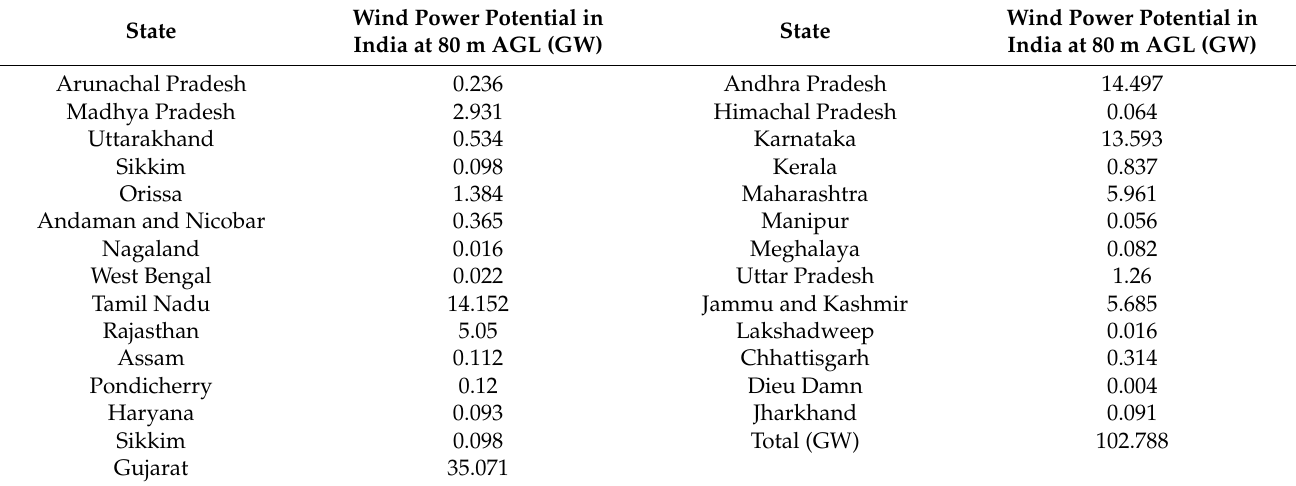
Table 13. Wind power potential in India at 80 m AGL (gigawatts). Source: NIWE, India [58].